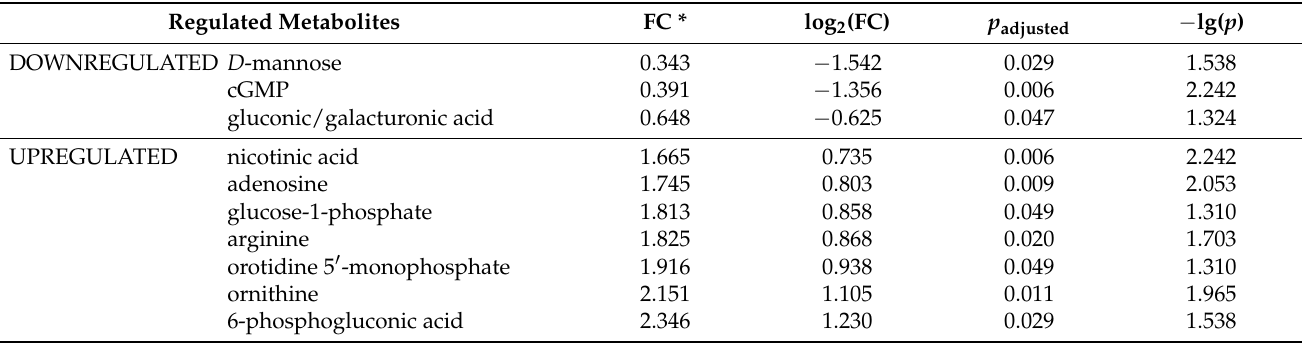
Table 1. Primary metabolites of Cucumis sativus roots demonstrating statistically significant regulation associated with the overexpression of CsRALF34